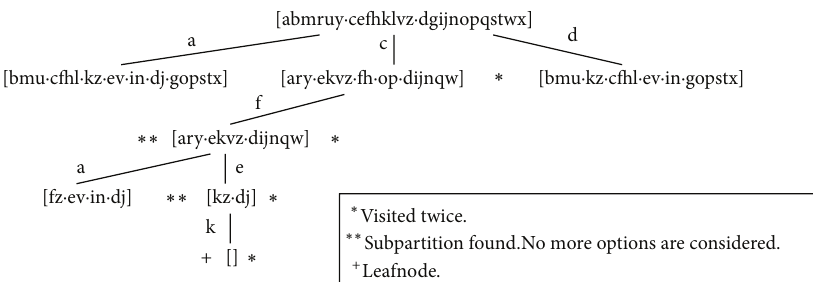
Figure 3: Generation of the first-path using DCS.